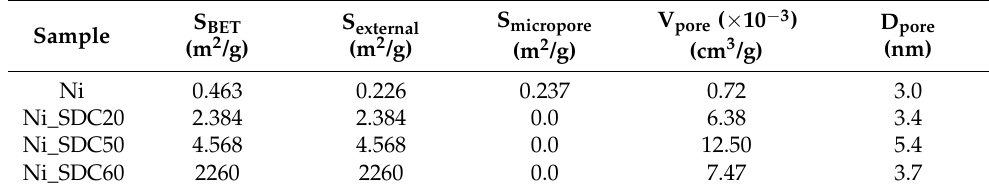
Figure 8. Physical nitrogen sorption analysis results comprising ( a ) obtained sorption isotherms and ( b ) pore size distributions. Table 2. Summary of the results obtained from the physical nitrogen sorption measurements such as the Brunauer–Emmett–Teller surface area (S BET ), external surface area (S external ), micropore surface area (S micropore ), pore volume (V pore ), and average pore diameter (D pore ).